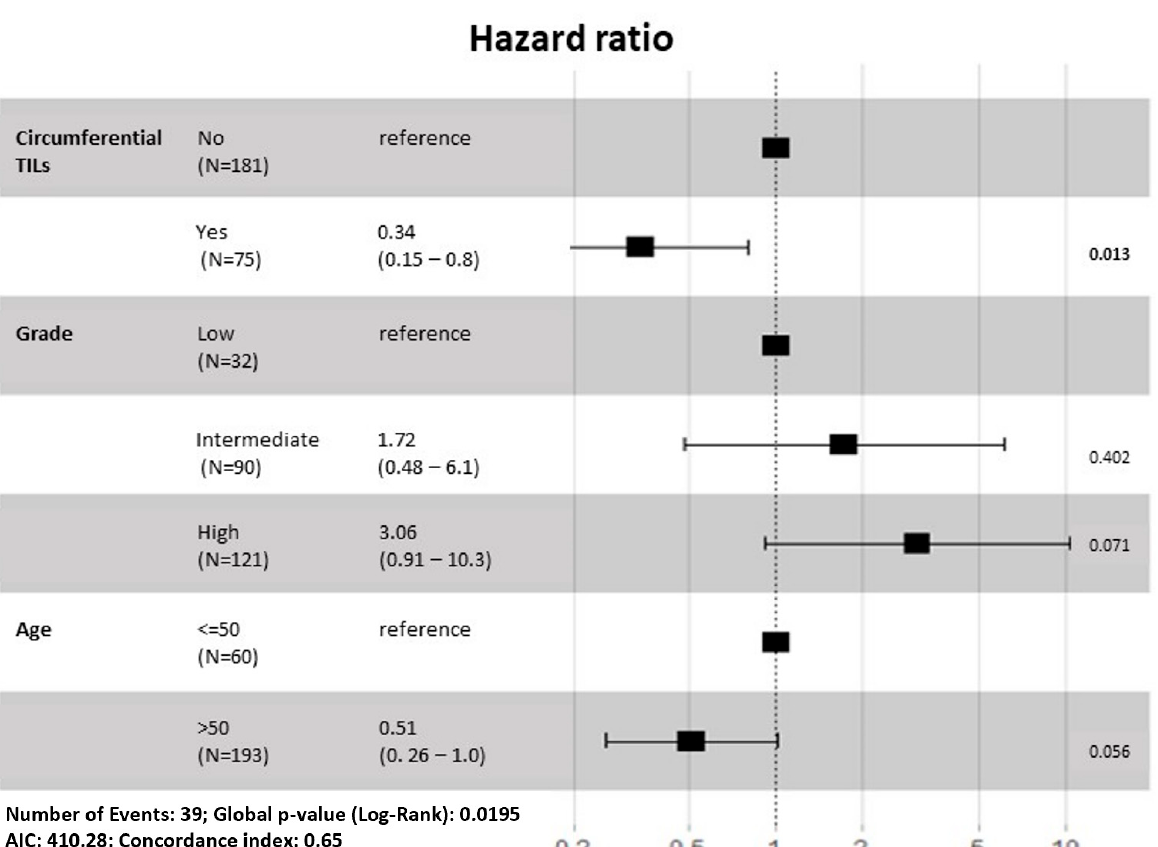
Figure 3. Forest plot of multivariable analysis of cohorts for tumor-infiltrating lymphocytes (TILs) assessments with clinical and histologic parameters. In total 3 variables were selected—age, grade, and circumferential TILs with significance (Wald test p = 0.01).